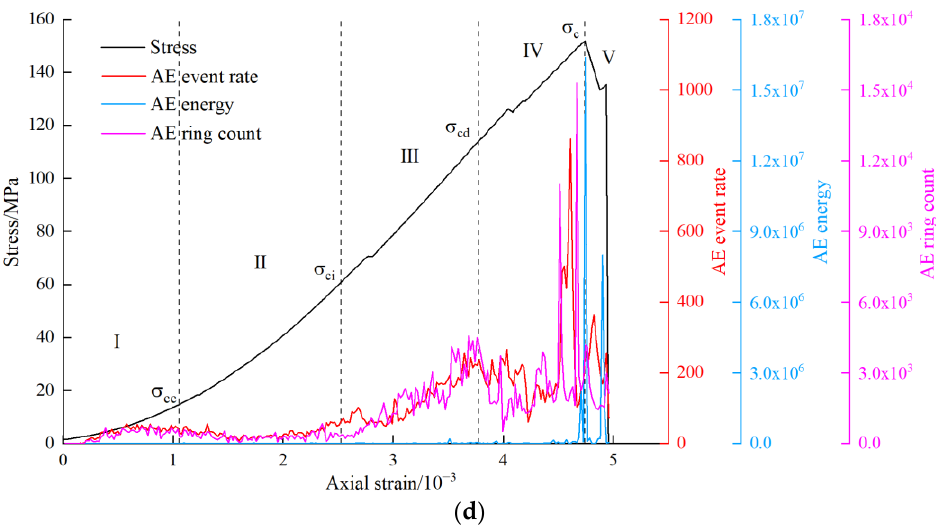
Figure 5. Variation features of AE characteristic parameters of the limestone at different stress stages. ( a ) The limestone without a rockburst tendency; ( b ) the limestone with a weak rockburst tendency; ( c ) the limestone with a medium rockburst tendency; and ( d ) the limestone with a strong rockburst tendency.